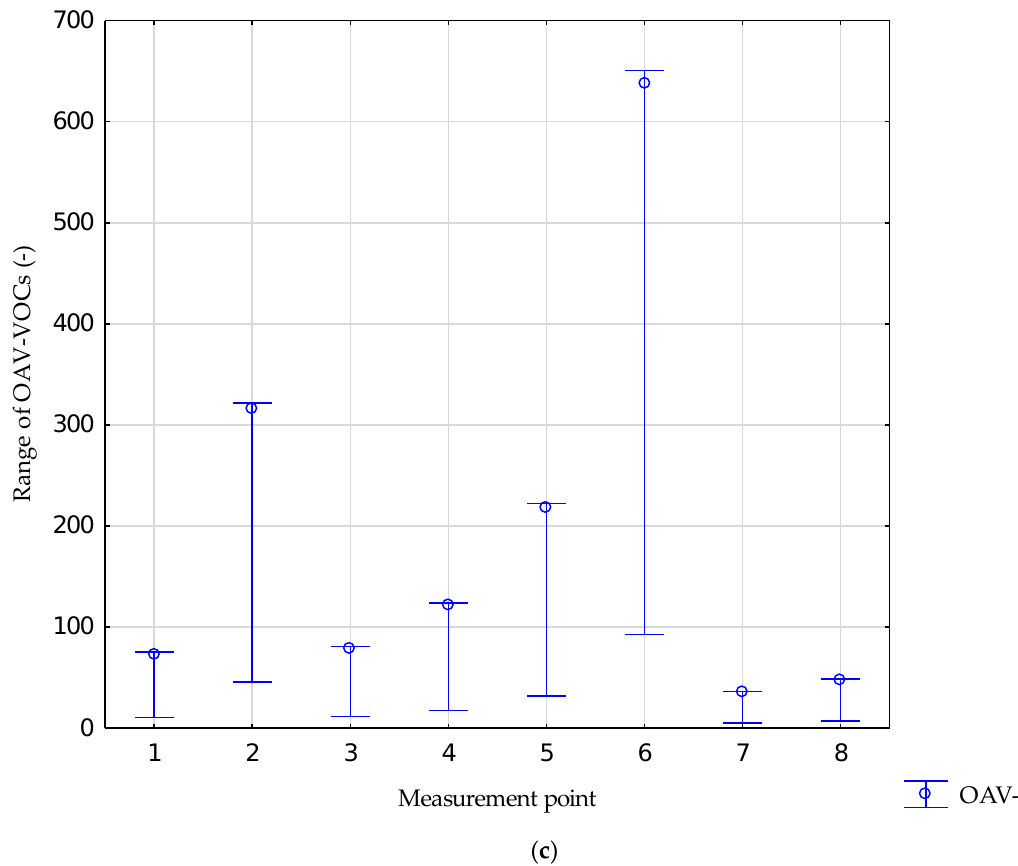
Figure 6. The results obtained at biogas plant located in Wólka Rokicka. ( a ) Odorant concentrations. ( b ) Odour activity values (based on toluene) and odour concentration at individual measurement points: 1, inside the waste storage plant; 2, mixed waste storage; 3, selectively collected waste storage; 4, mechanical treatment; 5, fermentation preparation; 6, oxygen stabilization; 7, technological wastewater pumping station; and 8, biofilter. ( c ) Range of odour activity values (based on toluene, styrene, and